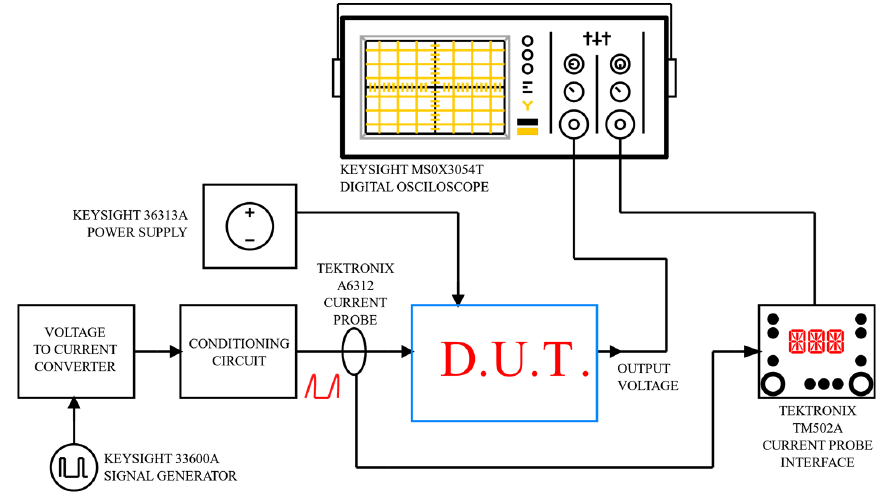
Figure 9. Discrete prototype board: top ( a ) and bottom ( b ) views.